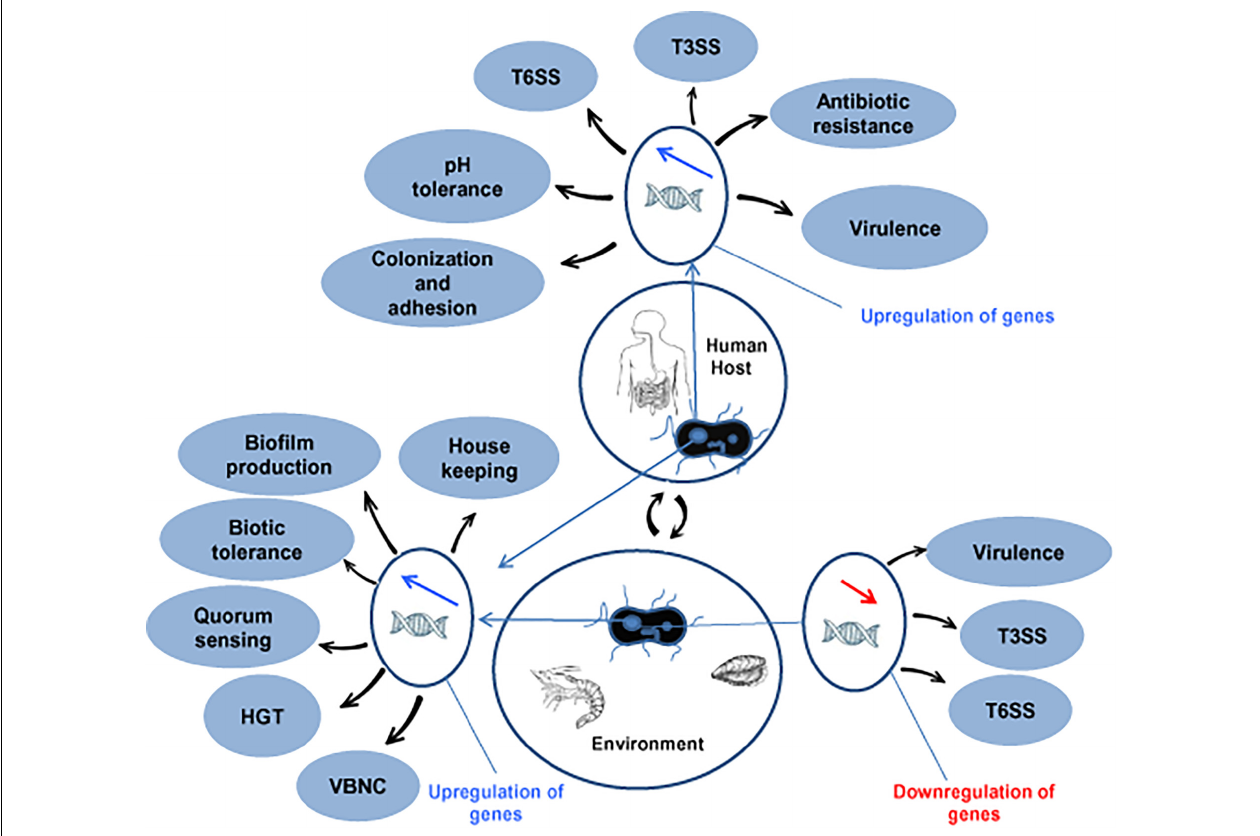
FIGURE 1 | Up- and downregulated in genes in V. parahaemolyticus for adaptation and fitness in human and environmental niches. HGT, horizontal gene transfer; VBNC, viable but non-culturable; T3SS, type III secretion system; T6SS, type VI secretion